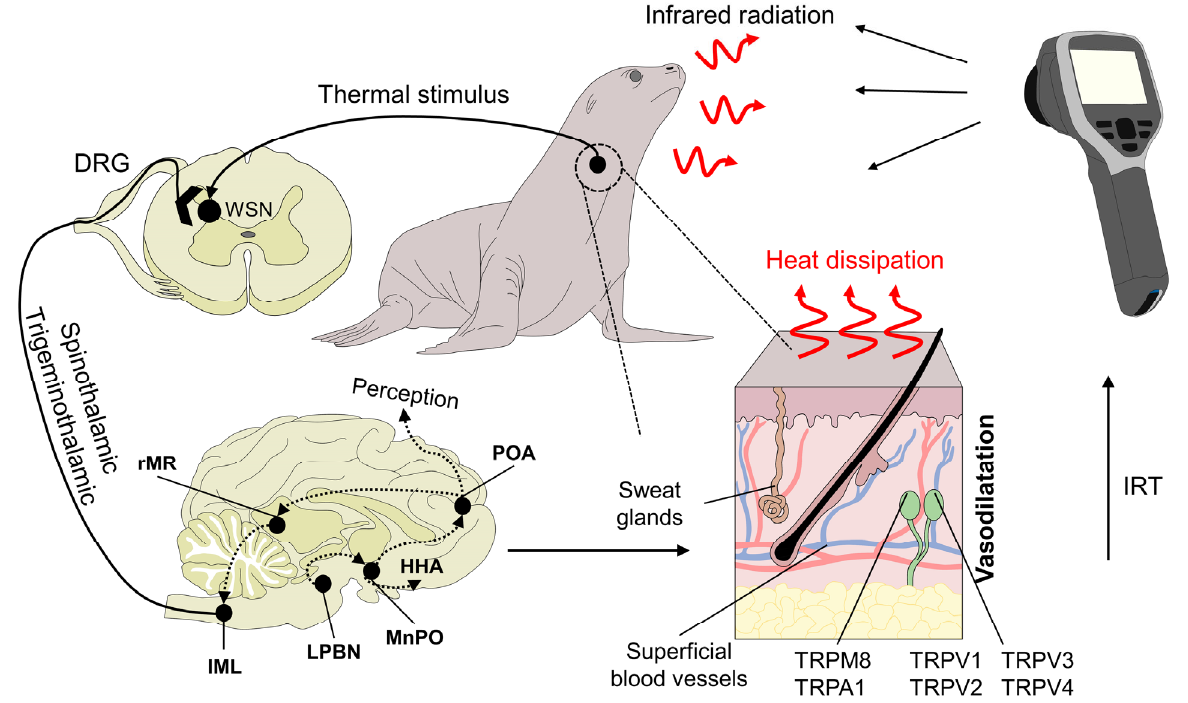
Figure 2. Physiological basis of infrared thermography and mechanisms of heat loss. Peripheral receptors in the dermal tissue, such as transient receptor potential vanilloid (TRPV, TRPV1, TRPV2, TRPV3, and TRPV4) or melastatin-related transient receptors (TRPM8), respond to heat and cold environmental stimuli, respectively. TRP ankyrin (A1) is postulated to have a function in noxious cold sensation and mechanosensation. These receptors initiate the transduction of the stimulus through primary peripheral nerve endings connected to secondary neurons in the spinal cord. Upon reaching this structure, warm ‐ sensitive neurons (WSN) are activated and project the signal along the spinothalamic and trigeminothalamic pathways. Both of these tracts are connected to higher brain structures, such as the lateral parabrachial nucleus (LPBN) and median preoptic nucleus (MnPO) in the preoptic area of the hypothalamus (POA). DRG: dorsal root ganglion. HHA: hypo ‐ thalamo ‐ hypophyseal ‐ adrenocortical. IRT: Infrared thermography. Their role is to generate behav ‐ ioral, autonomic, and neuroendocrine responses. One of the autonomic responses to heat stimuli is peripheral vasodilatation by sympatho ‐ adrenergic neurons in the rostral medullary raphe (rMR) and the intermediolateral nucleus of the spinal cord (IML), which increases heat dissipation. This response is captured by the lens of the infrared thermographic camera to generate a radiometric image.